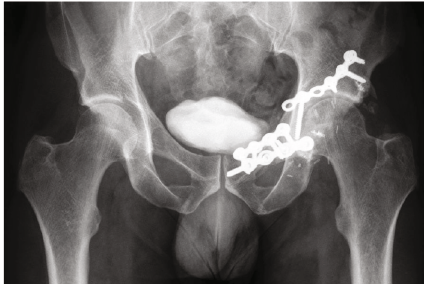
Figure 13: Plain fi lm at 30 months of follow-up showing a mild thinning of the joint